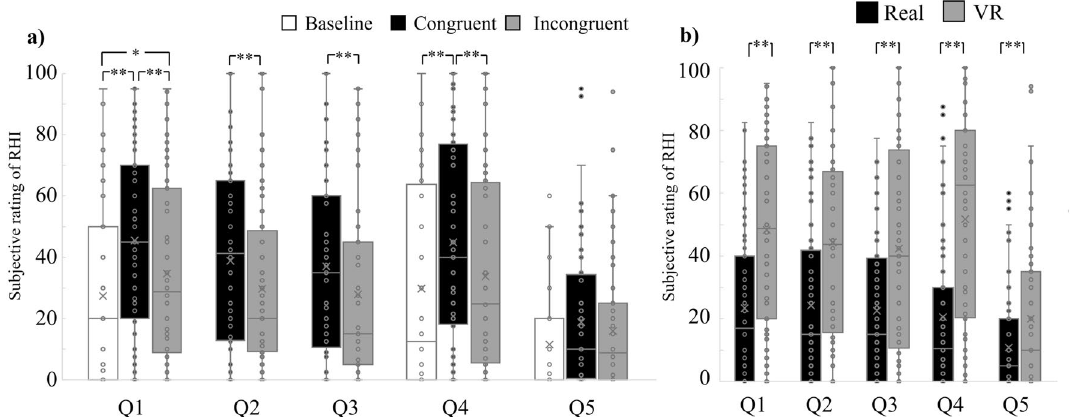
Figure 3. Boxplot of averaged RHI subjective ratings; the participants were requested to rank their experience with a number between 0 and 100, with 0 and 100 indicating “Did not feel it at all” and “Felt it very strongly,” respectively, to describe the extent to which they agreed with each stated feeling. Q1: “I felt as if the rubber hand was my hand;” Q2: “I felt as if the vibration was felt at the rubber hand;” Q3: “I felt as if the LED emitted at my hand;” Q4: “I felt as if my hand was located where the rubber hand was;” Q5: “I felt as if my hand was clad in rubber.” In the legend, “Real” and “VR” refer to the real and VR environments, respectively. The “Baseline” represents ratings given before the experimental session began. “Congruent” and “Incongruent” represent ratings obtained after stimulations in the congruent and incongruent conditions, respectively. ( a ) Averaged RHI subjective ratings for each stimulus combination and item, merged across environments. ( b ) Averaged RHI subjective ratings for each environment and item, merged across stimulus combinations. The circles inside and outside the boxplot are individual data points and outliers, respectively. The horizontal lines in the box indicate the median. The cross (x) marks in the box indicate the mean value for each condition. The bottom and top whiskers represent the first quartile minus 1.5*IQR (interquartile range) and the third quartile plus 1.5*IQR. * p < 0.05, ** p <